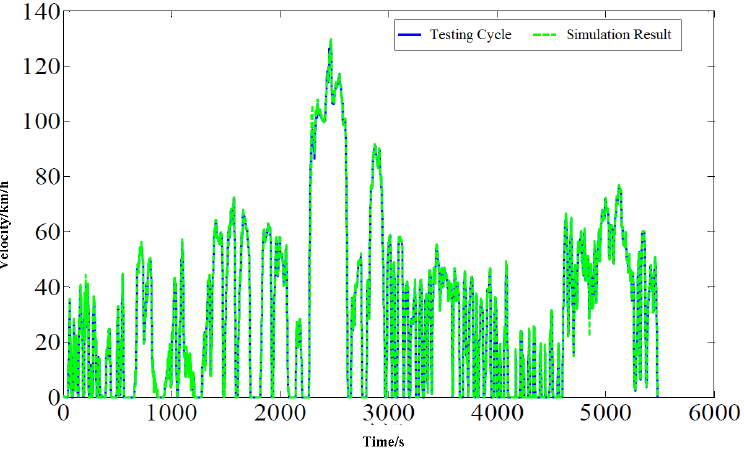
Figure 13. Cycle following comparison between the testing cycle and the simulation.